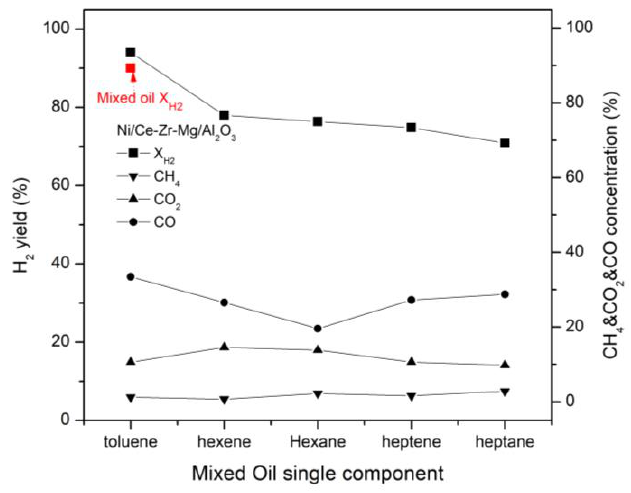
Figure 10. Effect of single components on hydrogen yield.(temp.=850 °C , S/C = 2, GHSV = 10,000h - 1 ).